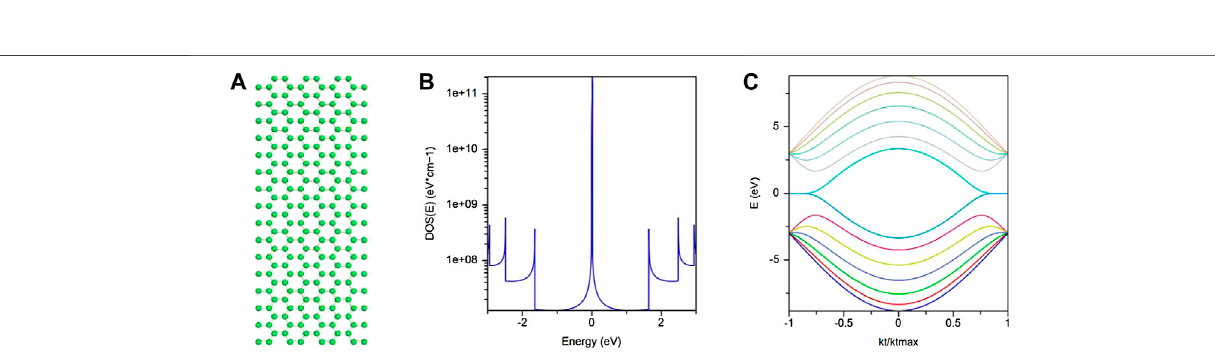
Frontiers in Physics |